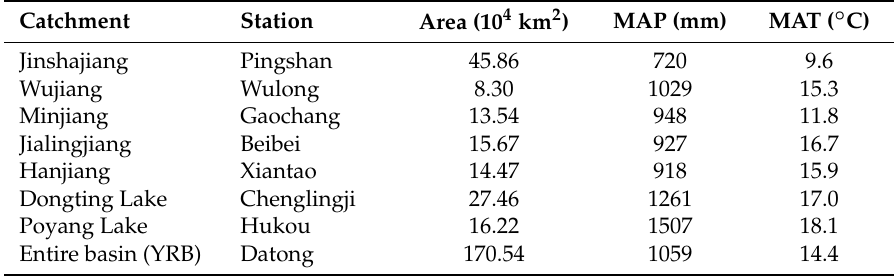
Table 1. Mean annual precipitation (MAP) and mean annual temperature (MAT) for the period 2003–2013, watershed area, and gauging stations over each